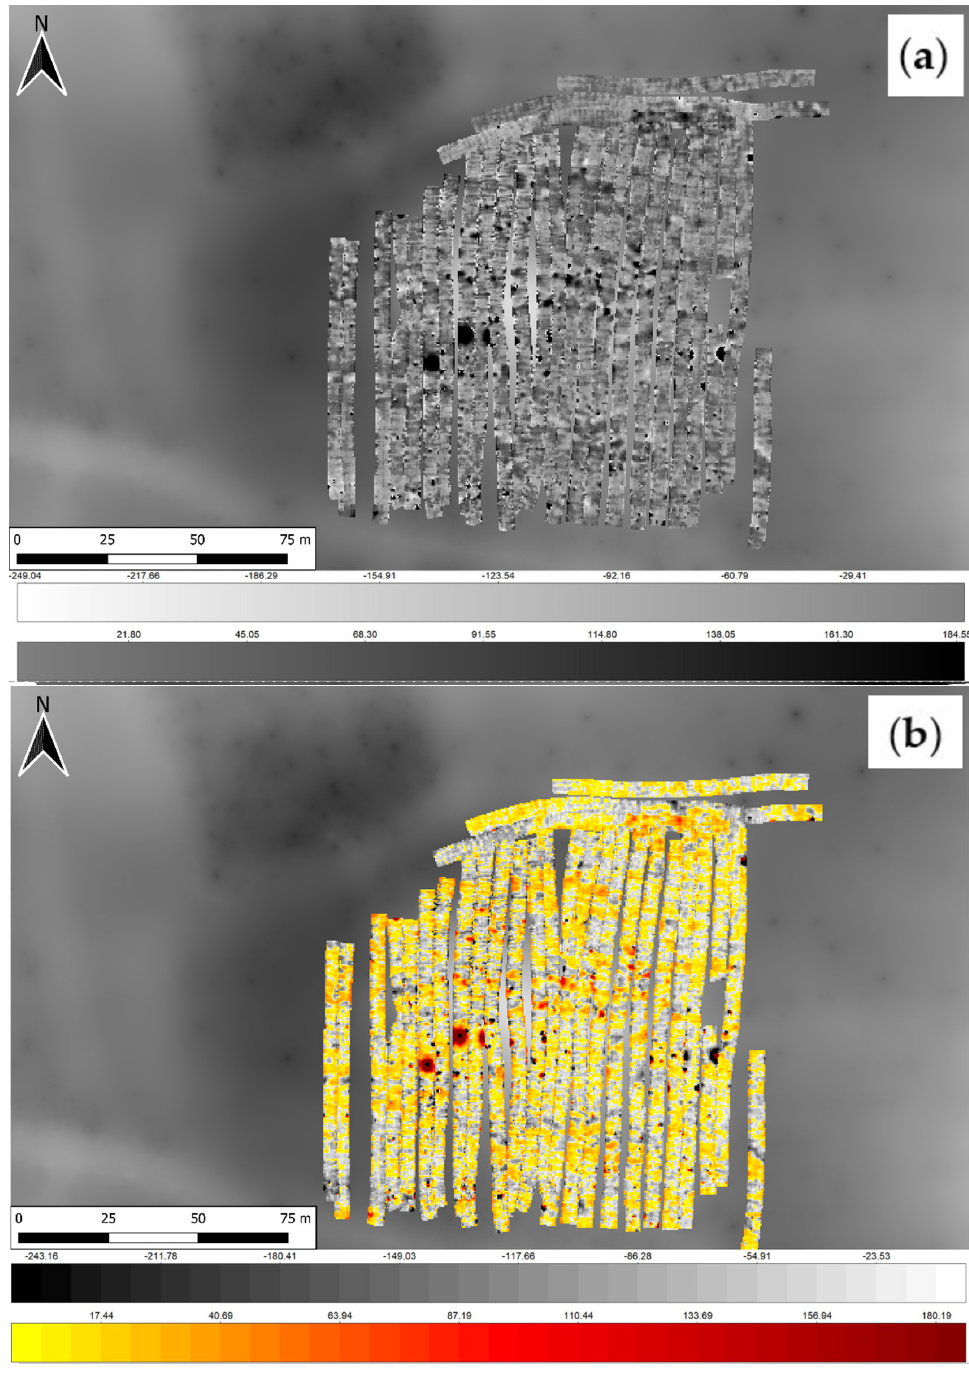
Figure 12. Results of the magnetic exploration carried out in the area of the El Toro necropolis. ( a ) Magnetogram with a grey scale representation; ( b ) Same magnetogram represented with a colouring scale ranging from red to black, depending on the positive/negative (+/ − ) values of the anomalies detected, represented between − 245 and +190